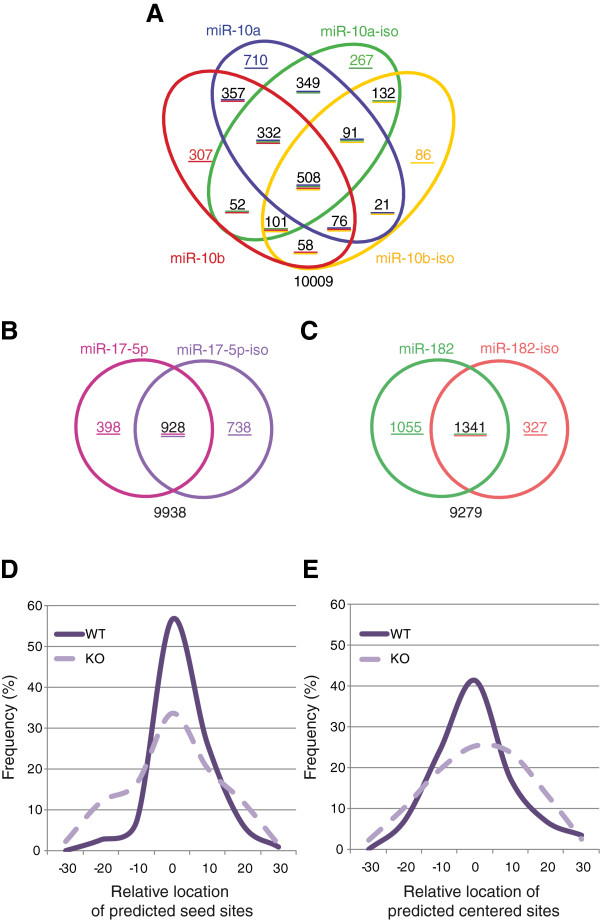
IsomiRs and canonical miRNAs target many of the same transcripts. (A-C) Venn diagrams indicating the number of microarray probes significantly enriched in each biotin pull-down and overlapping between related miRNAs. (D,E) Distribution of the location of predicted seed sites (D) and centered sites (E) relative to the center nucleotide of AGO2 peaks in mice wild-type for miR-155 (WT, solid line), or in miR-155 knock-out mice (KO, dashed line). AGO2 peaks were previously identified by Loeb et al.[20].